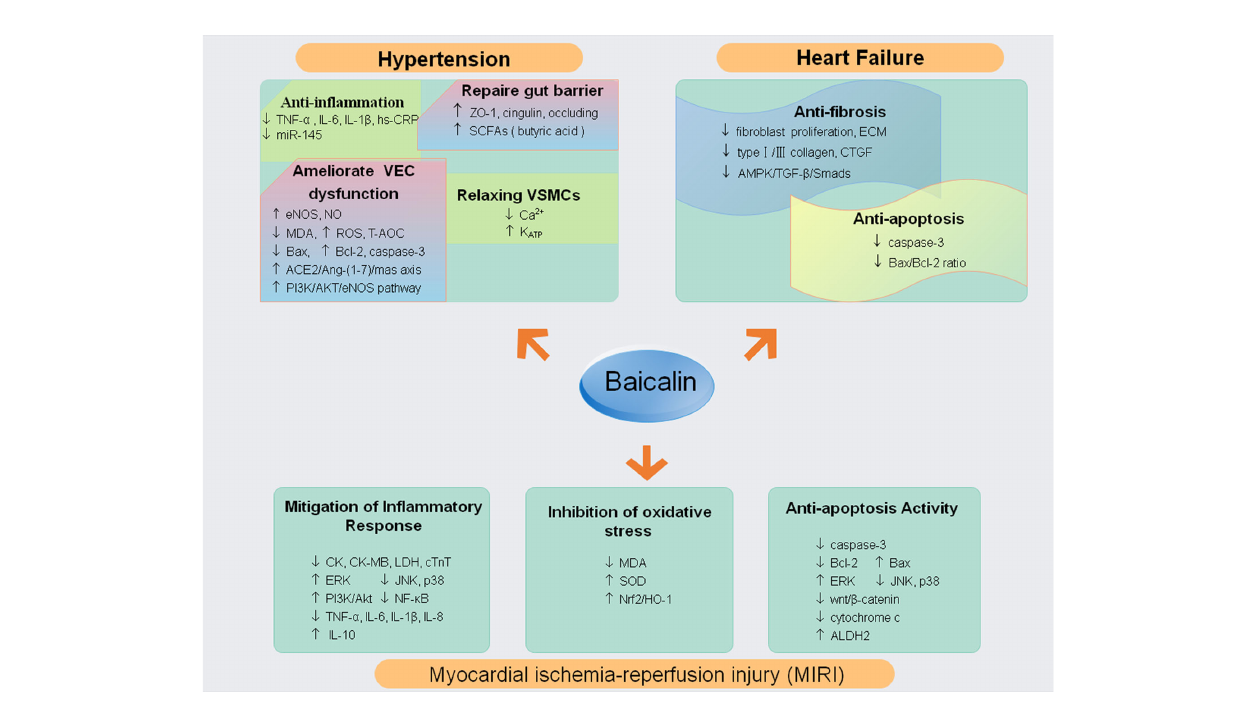
FIGURE 4 | The molecular mechanisms and potential targets of baicalin in hypertension, myocardial infarction and reperfusion, heart failure ( ↓ decrease or inhibit; ↑ increase or up-regulate). Abbreviations: tumor necrosis factor (TNF)- a ; extracellular signal-regulated kinase (ERK); c-Jun N-terminal kinase (JNK); phosphatidylinositol 3-kinase (PI3K); nuclear factor kappa B (NF- k B); interleukin 6, 8, 10, 1 b (IL-6, IL-1 b , IL-8,IL-10); superoxide dismutase (SOD); malondialdehyde (MDA); nuclear factor E2-associated factor 2 (Nrf2); heme oxygenase-1 (HO-1); mitogen-activated protein kinases (MAPKs); mitochondrial aldehyde dehydrogenase 2 (ALDH2); high- sensitivity C-reactive protein (hs-CRP); zonula occludens-1 (ZO-1); Short-chain fatty acids (SCFAs); oxygen reactive species (ROS);(eNOS);Total Antioxidant Capacity (T-AOC); nitric oxide (NO); extracellular matrix (ECM); Connective Tissue Growth Factor (CTGF); creatine kinase (CK), creatine kinase MB (CK-MB), lactate dehydrogenase (LDH) and serum cardial troponinT (cTnT); malondialdehyde (MDA); superoxide dismutase